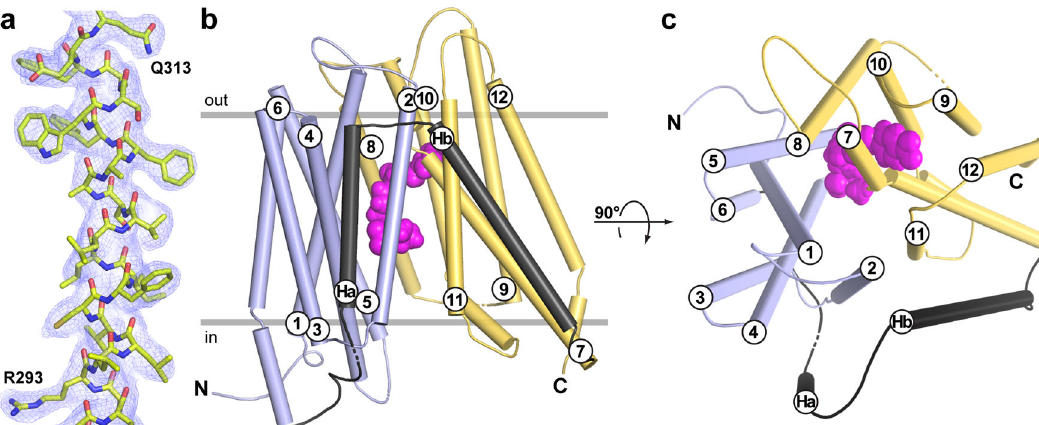
Fig. 2 Electron density and overall structure of YePEPT K314A with bound LZNV. a Electron density map of the YePEPT K314A crystal structure. Displayed is the 2Fo-Fc electron density map of a structural fragment of TM7 contoured at 1.0 σ and coloured in blue, and the YePEPT K314A structure as yellow sticks. The shown fragment of TM7 corresponds to the sequence 293- R LLVCFILLVSAAFFWSAFE Q -313, whereby residues in bold are labelled in the panel. b and c Overall structure of YePEPT K314A with bound LZNV in an inward-facing conformation. The structure is viewed as from the membrane plane ( b ) and from the periplasm ( c ). Grey horizontal lines in b indicate the orientation of YePEPT K314A in the biological membrane according to the PPM-server 70 . In b and c , the bound LZNV molecule is shown in purple as space- fi lling model. The N- and C-termini are indicated in capital letters and all 14 TMs are labelled N-terminally ( b ) or at the periplasmic side ( c ). The pseudo-twofold symmetrical N- and C-terminal six-helix bundles are coloured in blue and yellow, respectively, whereas the two bundles connecting helices (Ha and Hb) are depicted in black.